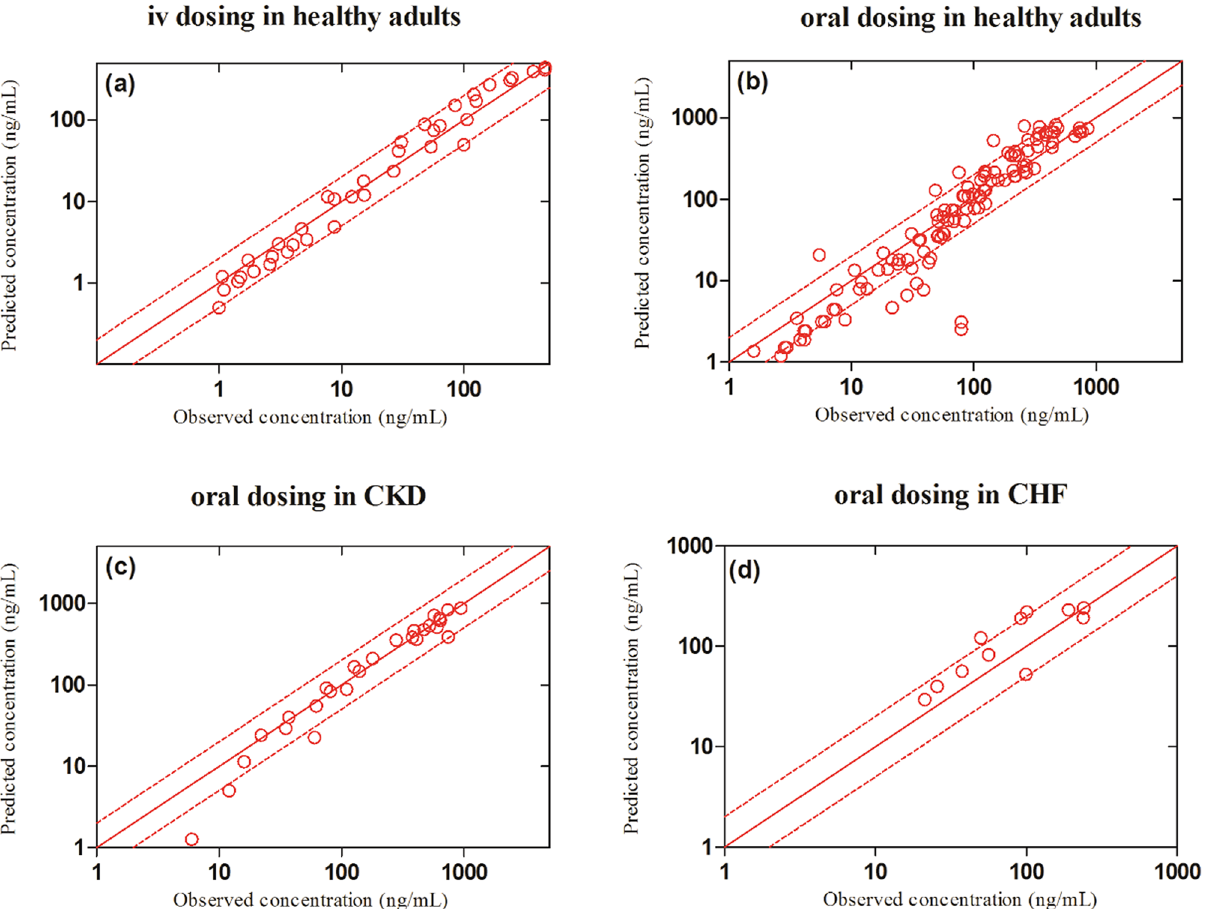
Figure 4. The observed versus predicted captopril systemic concentration plots in healthy and diseased populations. The (red circles) represent the observed vs predicted captopril concentrations. The (red solid line) indicates the line of identity; the (red dashed line) indicates a two-fold error